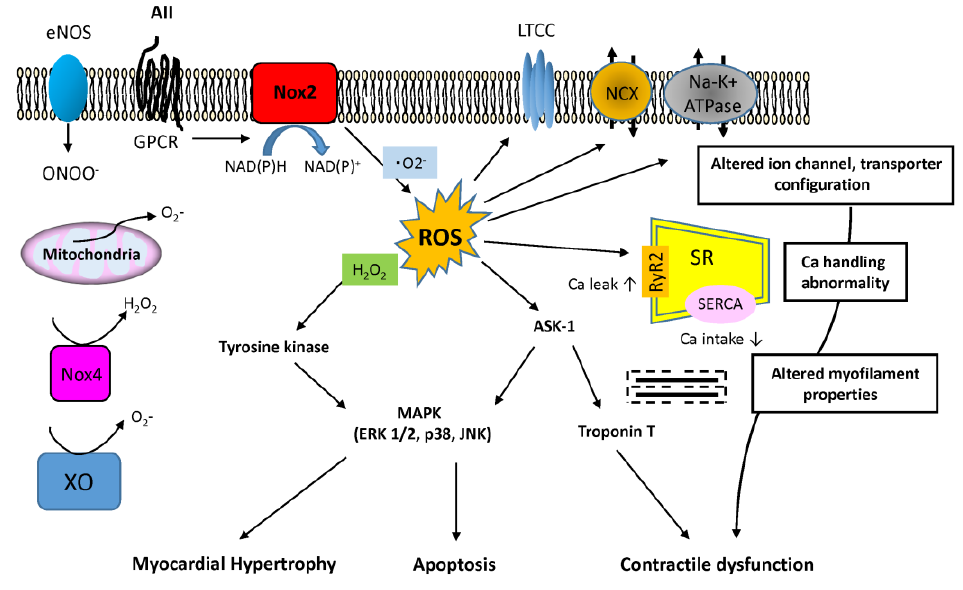
Figure 5. AII-associated ROS pathway and alternation of the structure and